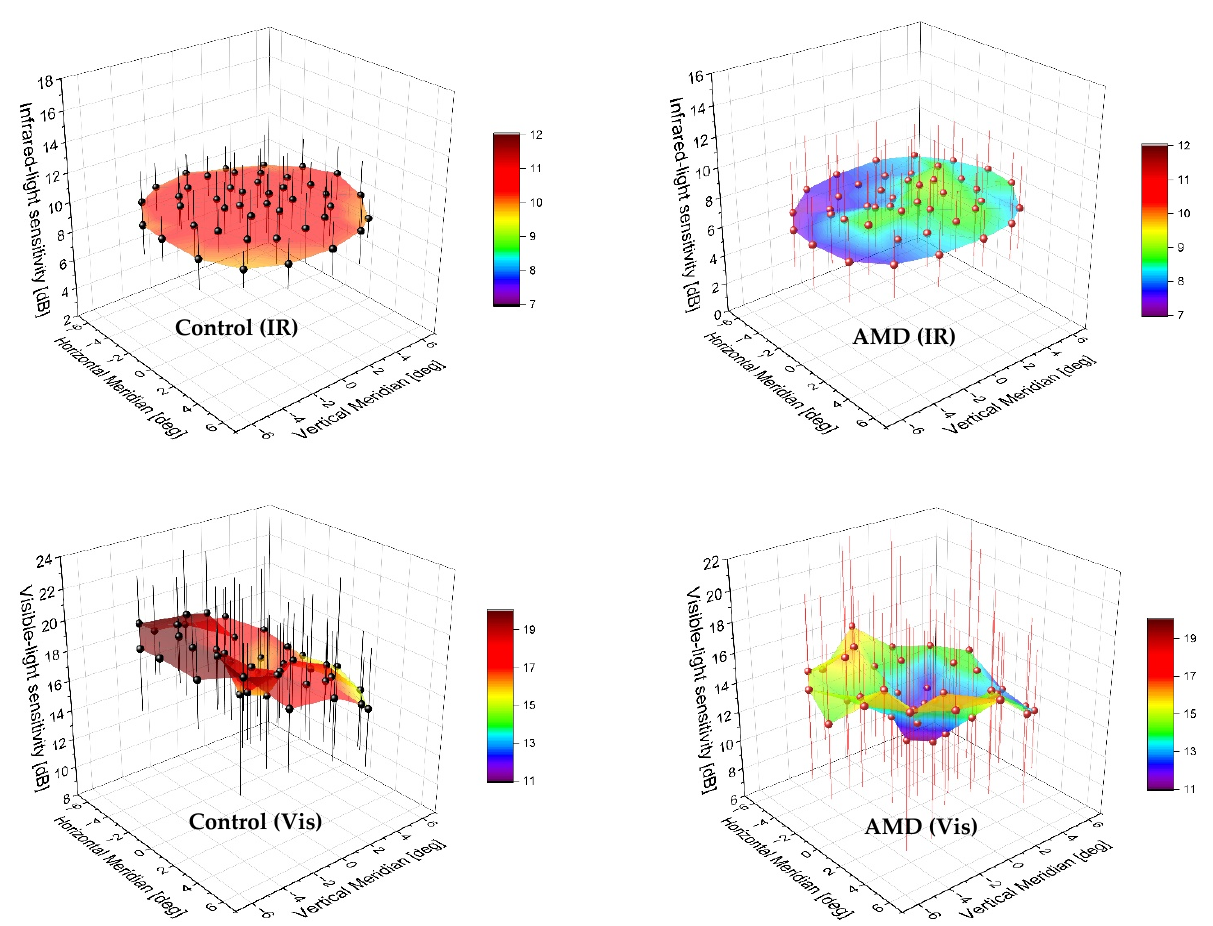
Figure 6. Retinal sensitivity maps of control (left panels) and AMD (right panels) participants compared using visible-light (Vis) microperimetry (upper panels) and two-photon mediated infrared light (IR) stimulation (lower panels). A triangular approach was applied to interpolate the area (colored gradient) between 44 measured loci (solid points). Control subjects’ results were marked in black; red marking indicates AMD patients. Error bars = interquartile range.